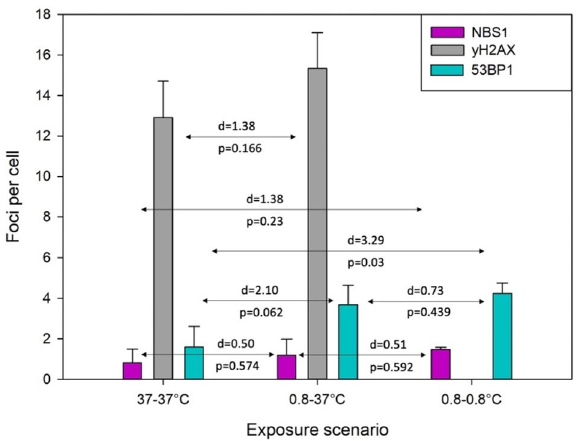
Figure 5. Frequencies of spontaneous foci in U2OS cells exposed to hypothermia without irradiation. Results represent mean values from 3 experiments with NBS1, 53BP1 and γH2AX foci. Error bars represent standard deviations from 3 experiments. D values represent Cohen’s d values. p values represent significance level from two-sided Student’s t test, assuming unequal variance. See Fig. 1A for explanation of the exposure